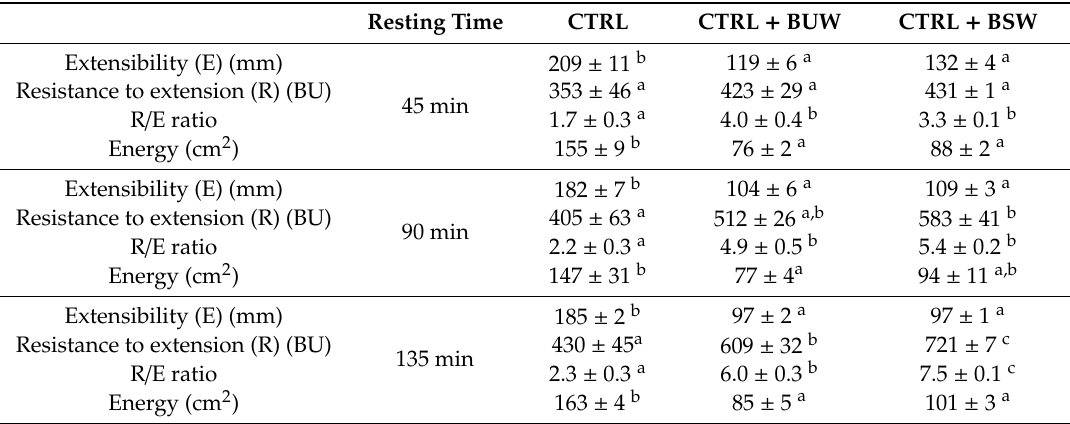
Table 3. Extensibility properties of refined wheat flour alone, with bran from un-sprouted wheat, or bran from sprouted wheat.